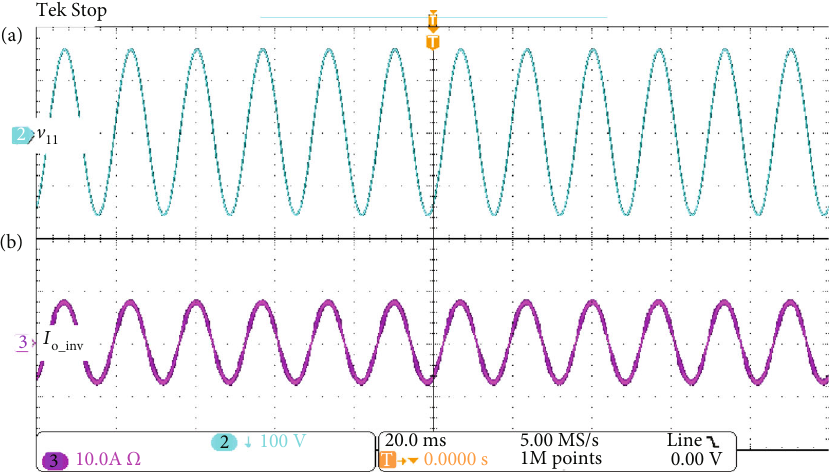
, 100V/div); (b) current in residence 11 ( I 11